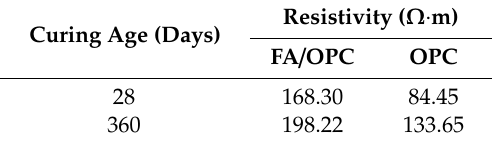
Table 1. Resistivity of the FA / OPC and OPC concretes at 28 and 360 days of